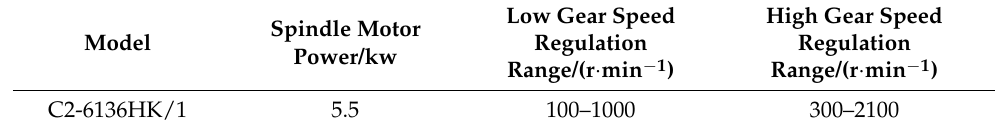
Table 2. Selection range of cutting parameters.